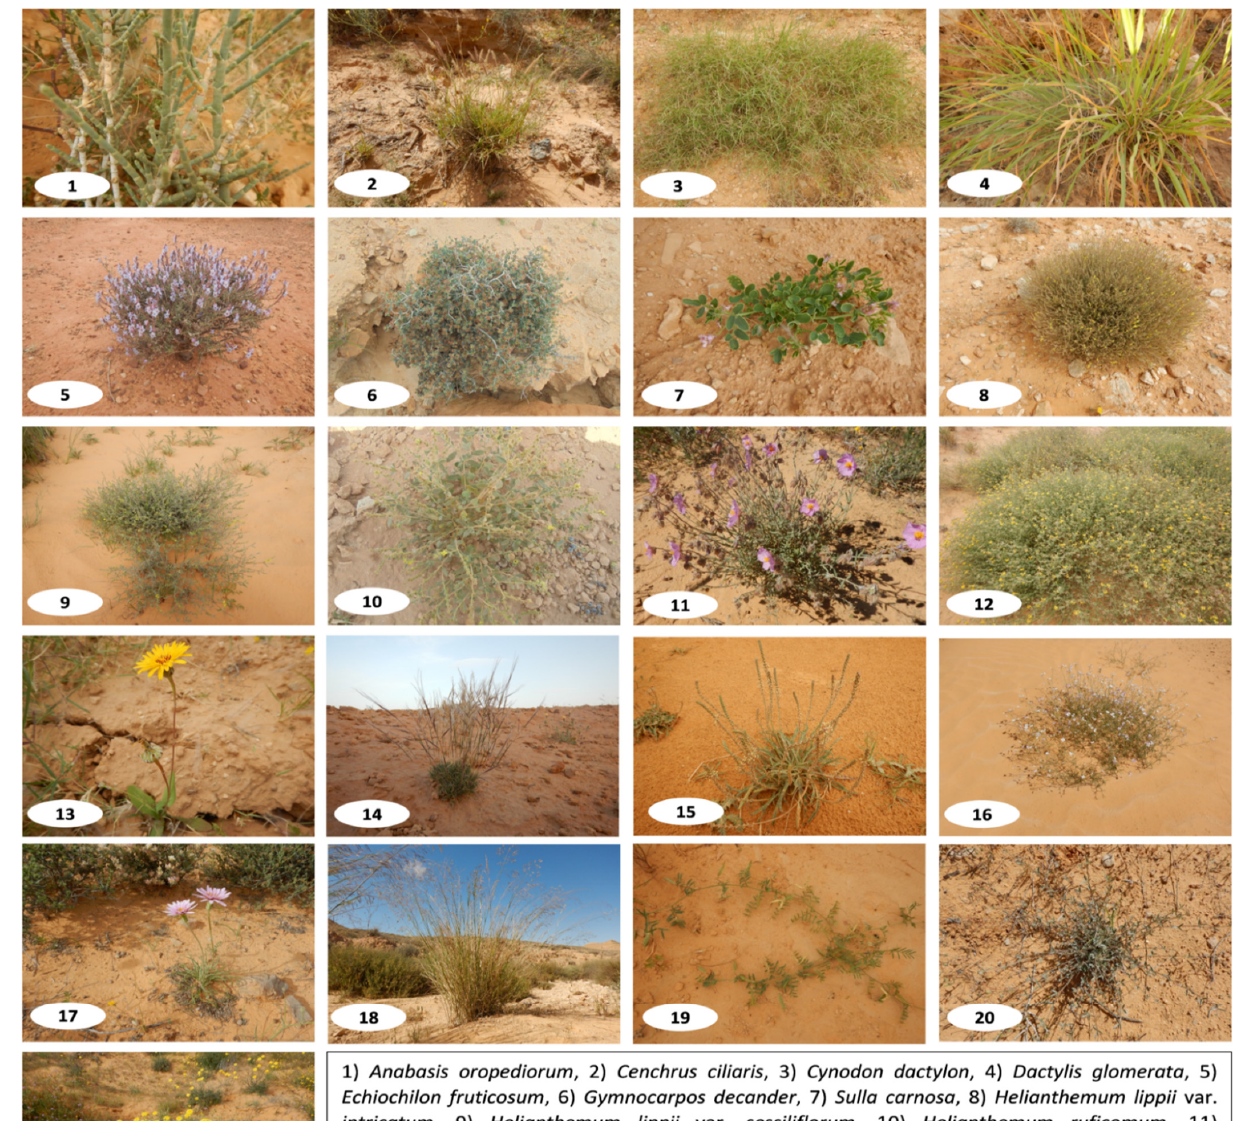
Figure 7. The main highly palatable species (palatability index (PI) = 5) recorded in the arid and desert rangelands of Tataouine, Tunisia (spring 2018) (Photos by Mouldi Gamoun).